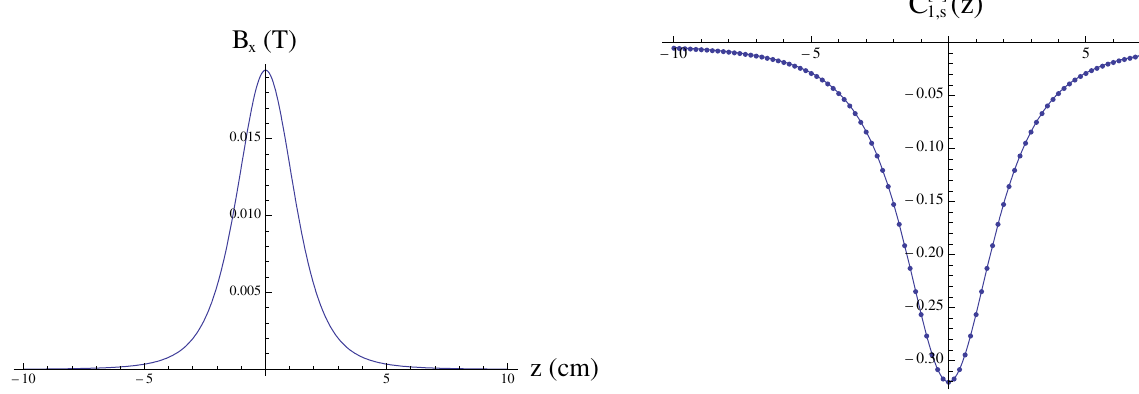
on the line (cid:1) ¼ 1 = 2 , FIG. 11. (Color) Exact and numerical results for C ½ 0 (cid:3) 1 x results are shown as a solid line, and numerical results are shown as